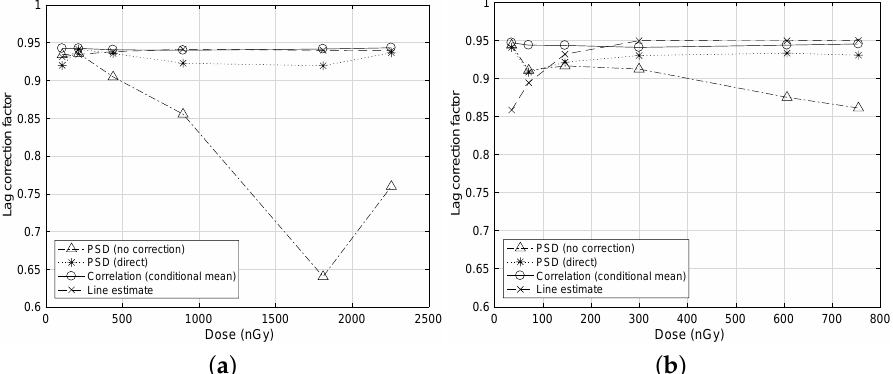
Figure 5. Comparison of the LCF measurements. “PSD (no correction)” is the method of IEC62220-1-3 without the NTG correction, and “PSD (direct)” is the PSD method with the direct correction [22]. “Correlation (conditional mean)” is the proposed algorithm, and “Line estimate” is the line estimate method [13]. ( a ) Frame rate of 10 fps; ( b ) Frame rate of 30